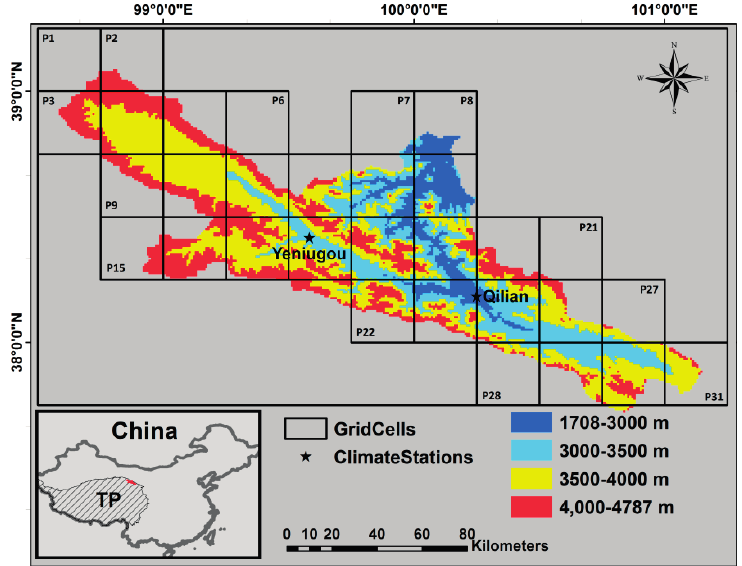
Figure 1. Drainage basin of the upper Heihe River, Northeast edge of the Tibetan Plateau (TP) (shadow area of the inset map), with two weather stations: Qilian (2787 m) and Yeniugou (3320 m) denoted as black stars. The basin is segmented into four elevation zones. Zone a: 1708–3000 m, Zone b: 3000–3500 m, zone c: 3500–4000 m, and Zone d: 4000–4787 m. The 31 grid cells (25 km × 25 km) are extracted from APHRODITE precipitation